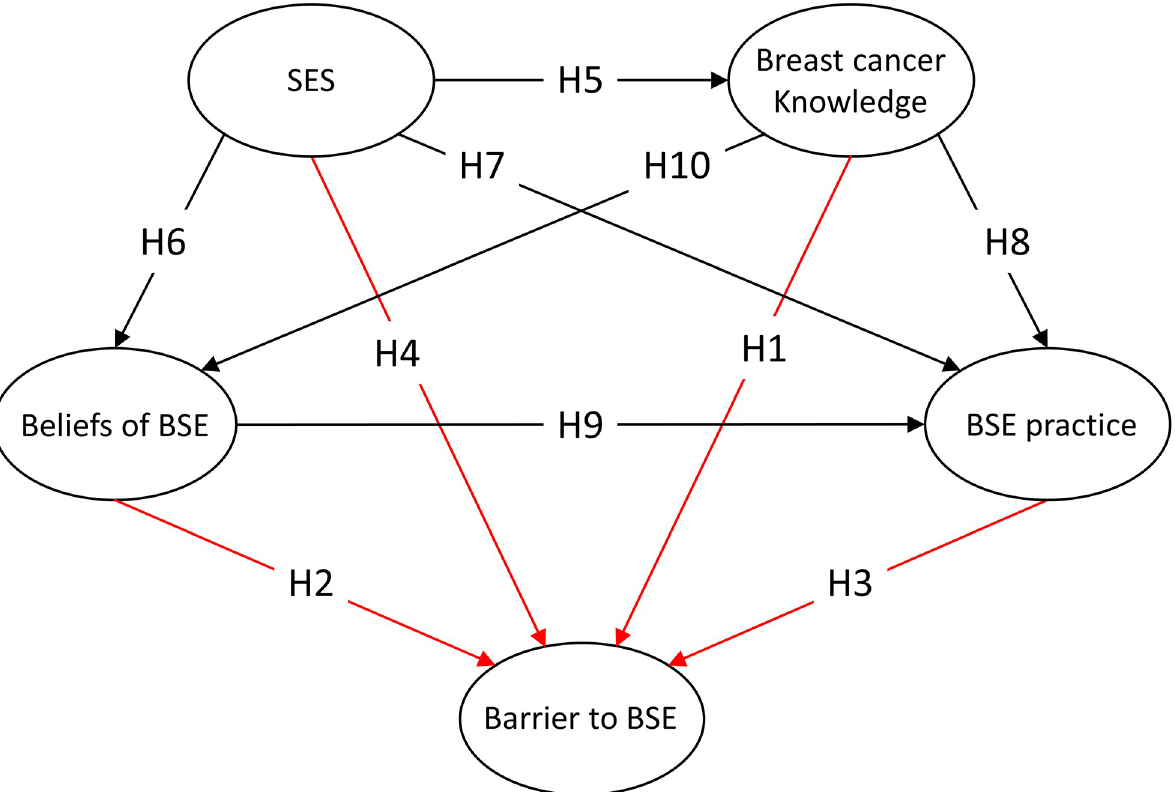
Fig 1. The original hypothetical model (M1). SES, Socioeconomic status; BSE, breast self-examination.